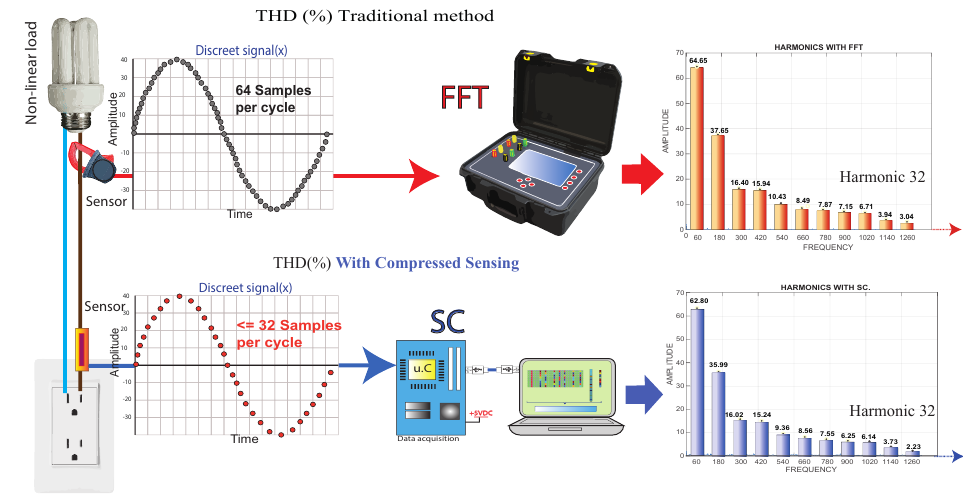
Figure 2. Methodology used for the problem